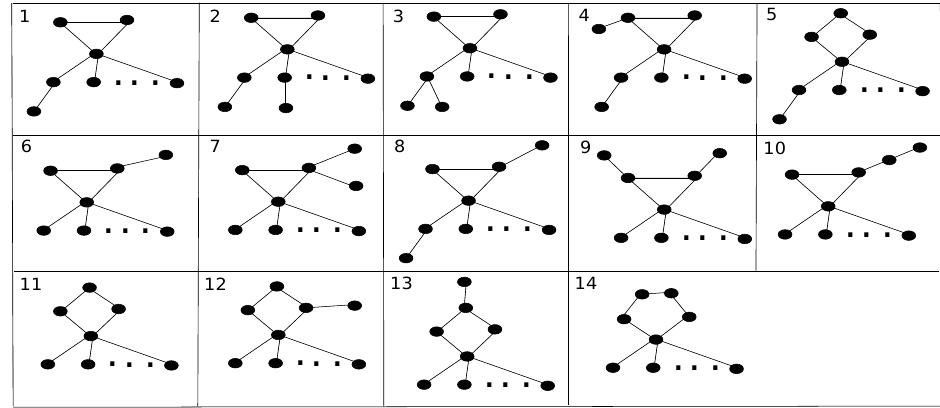
Figure 9. The graphs with second maximal or third maximal Resistance-Harary